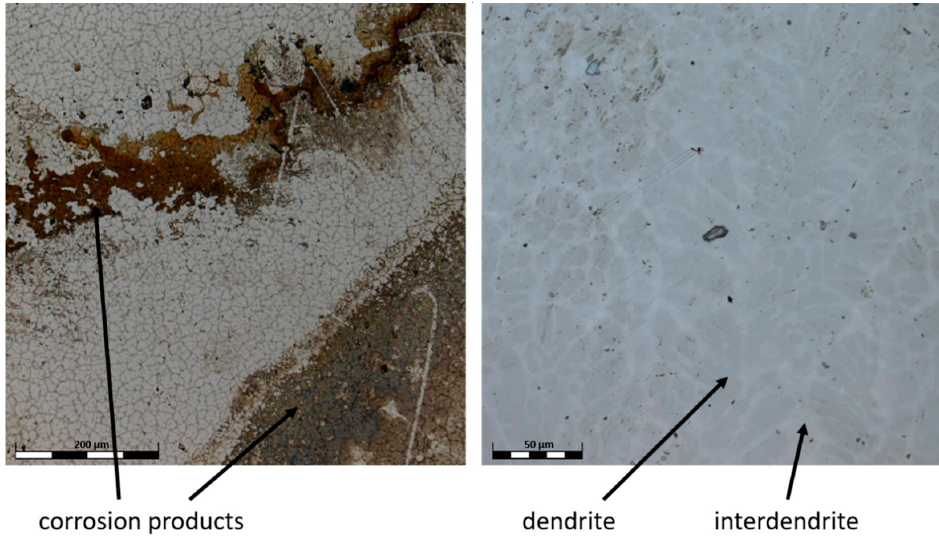
Figure 8. Confocal image of the TiAlFeCoNi surface after corrosion test.